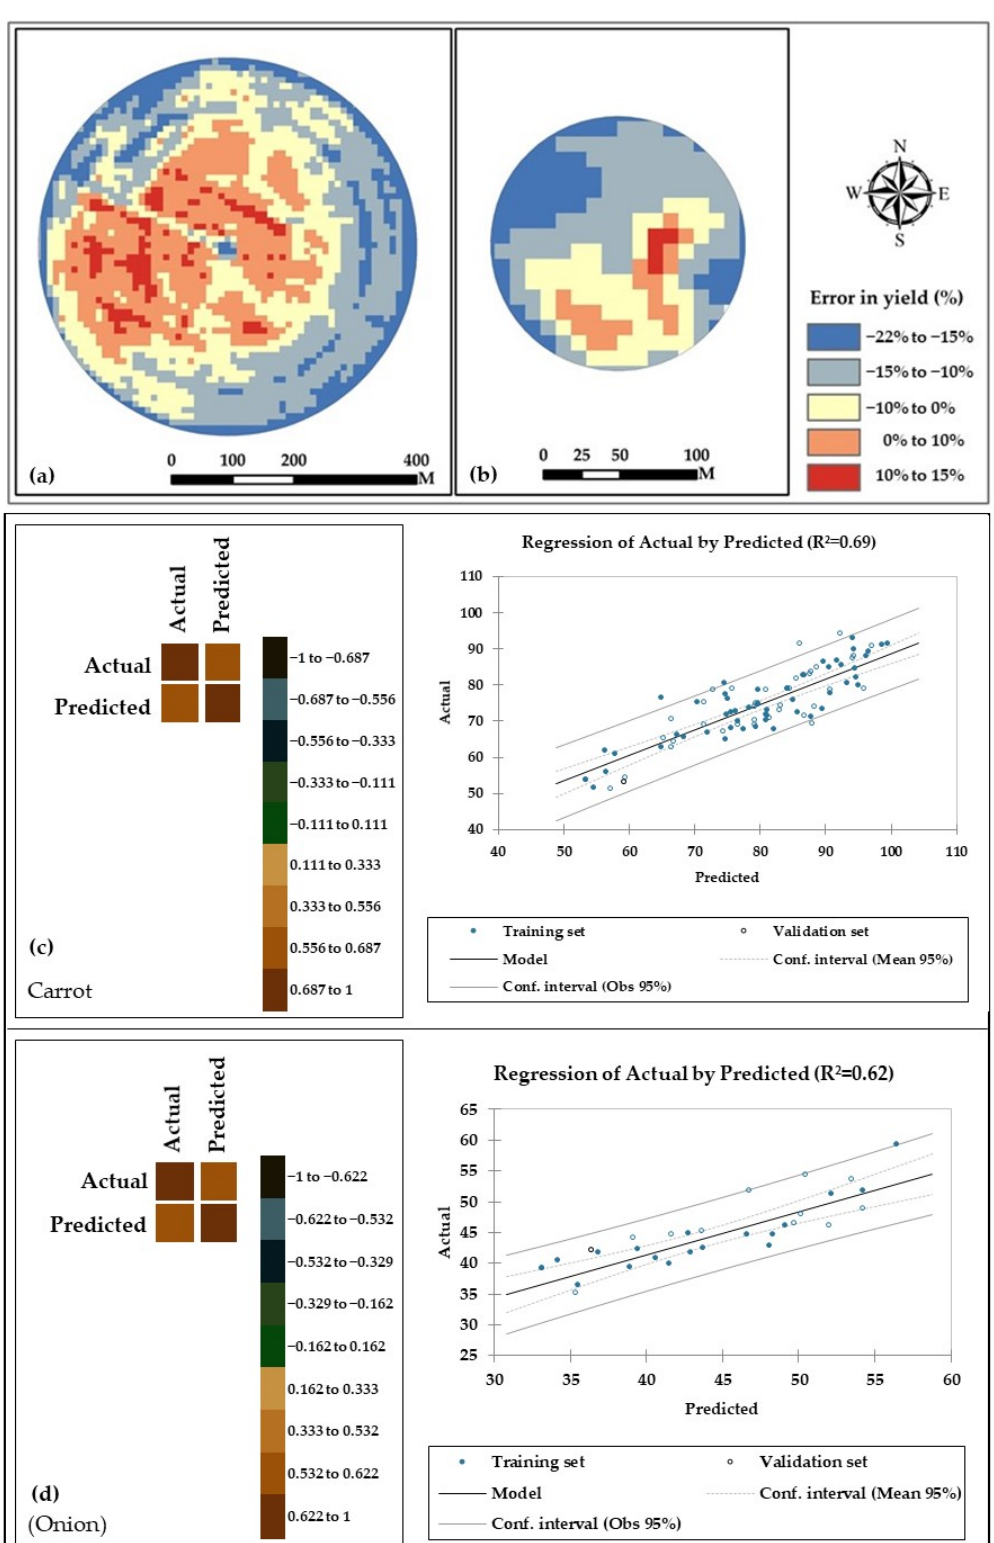
Figure 9. Scatter plots with regression analysis between estimates and actual yield data of the studied crops: carrots ( a ); onions ( b ). Regression maps: carrots ( c ) and onions ( d ). The blue corresponds to a correlation close to − 1 and the brown to a correlation close to